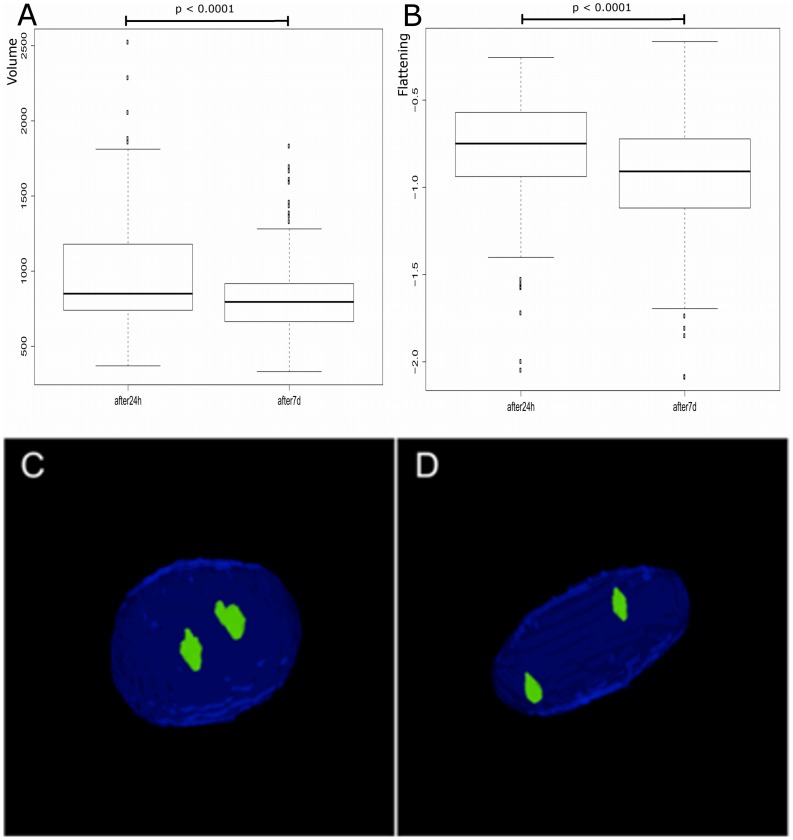
Morphological comparison of myoblast and myotube nuclei.Nuclei of differentiated myotubes have been characterised by a smaller volume (A) and increased flattening (B) compared to proliferating myoblasts. In both cases, differences were statistically significant (p<0.00001). C – 3D projection of myoblast D – myotube nucleus with a signal detected for chromosome centromeres.